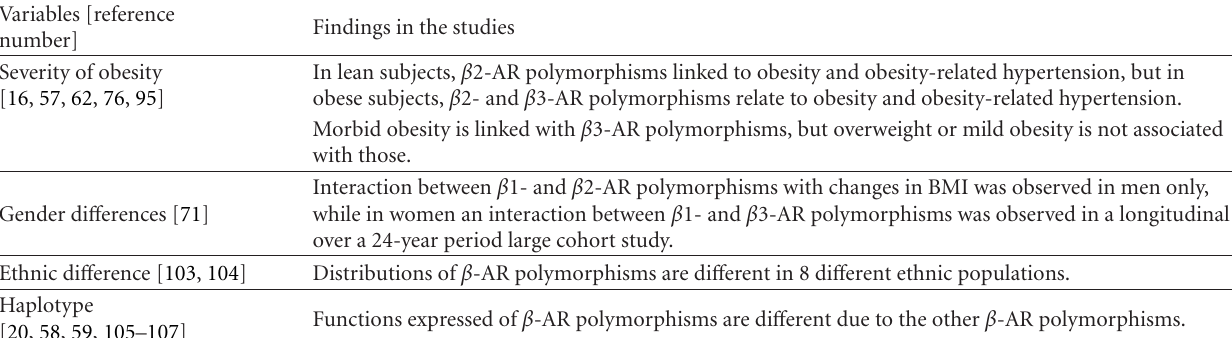
In lean subjects, β 2-AR polymorphisms linked to obesity and obesity-related hypertension, but in